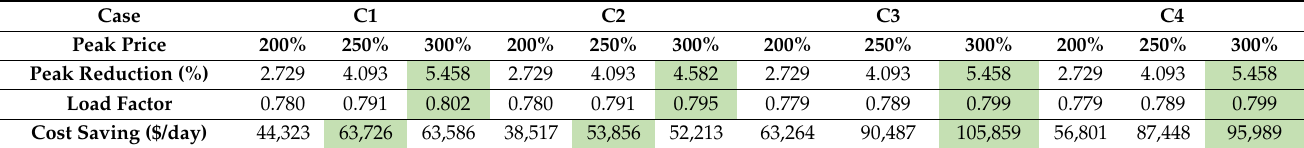
Figure 23. Cost saving. Table 14. Cases [C1–C4] results.